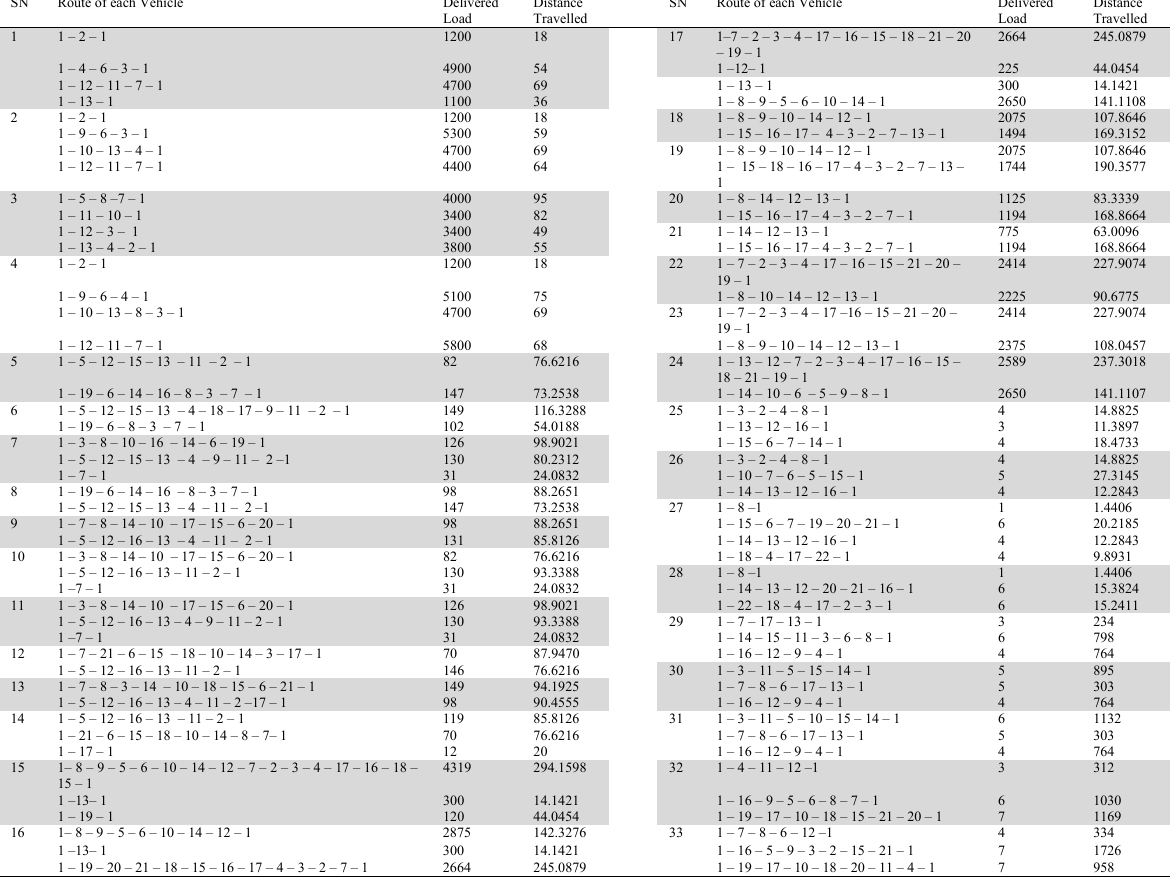
Table 4 The LPG distribution route plan corresponding to the optimal fractional solution of CTVRP SN Route of each